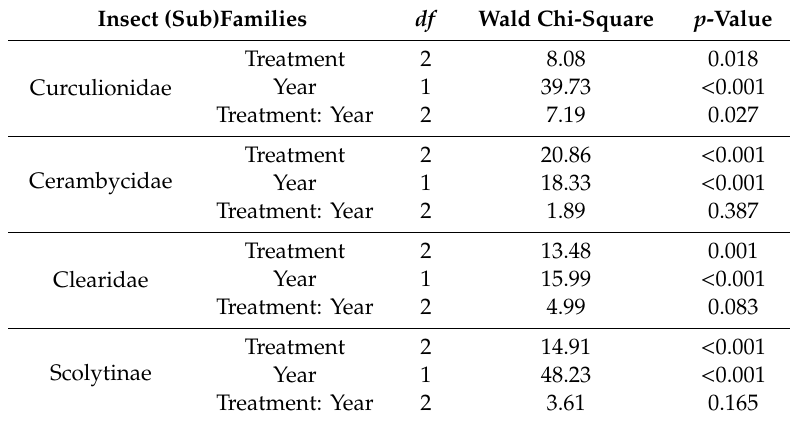
Table 2. Fixed e ff ects and interaction terms of deadwood supply treatment and sampling year on the daily capture of saproxylic beetles, based on Type III Wald χ 2